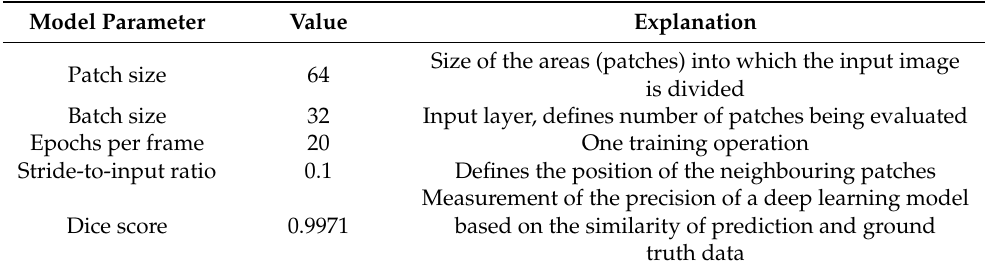
Table 3. Model architecture of the DL